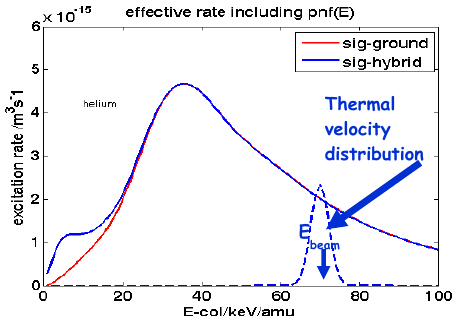
Figure 17. Schematic presentation of Cross-section effects: Frist order gradients d σ /dv lead to apparent Doppler shift, second order gradients d 2 σ /dv 2 lead to apparent Doppler width.